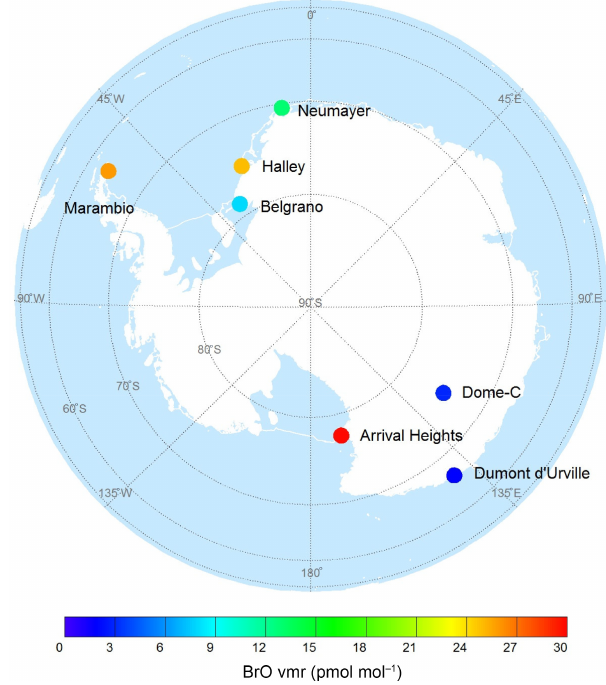
Figure 11. Maximum values of BrO vmr reported in the low tropo- sphere of Antarctica as measured with ground-based observations. The different sites where BrO has been reported in the low tropo- sphere are indicated with a colored dot. The color code of each dot (station) refers to the maximum BrO vmr reported in literature (Ar- rival Heights: Kreher et al., 1997; Neumayer: Frieß et al., 2004; Dumont d’Urville: Grilli et al., 2013; Halley: Roscoe et al., 2014; Dome-C: Frey et al., 2015; Marambio and Belgrano: this work). Note that only the present study provides contemporary observa- tions from different sites. Further details are provided on Table